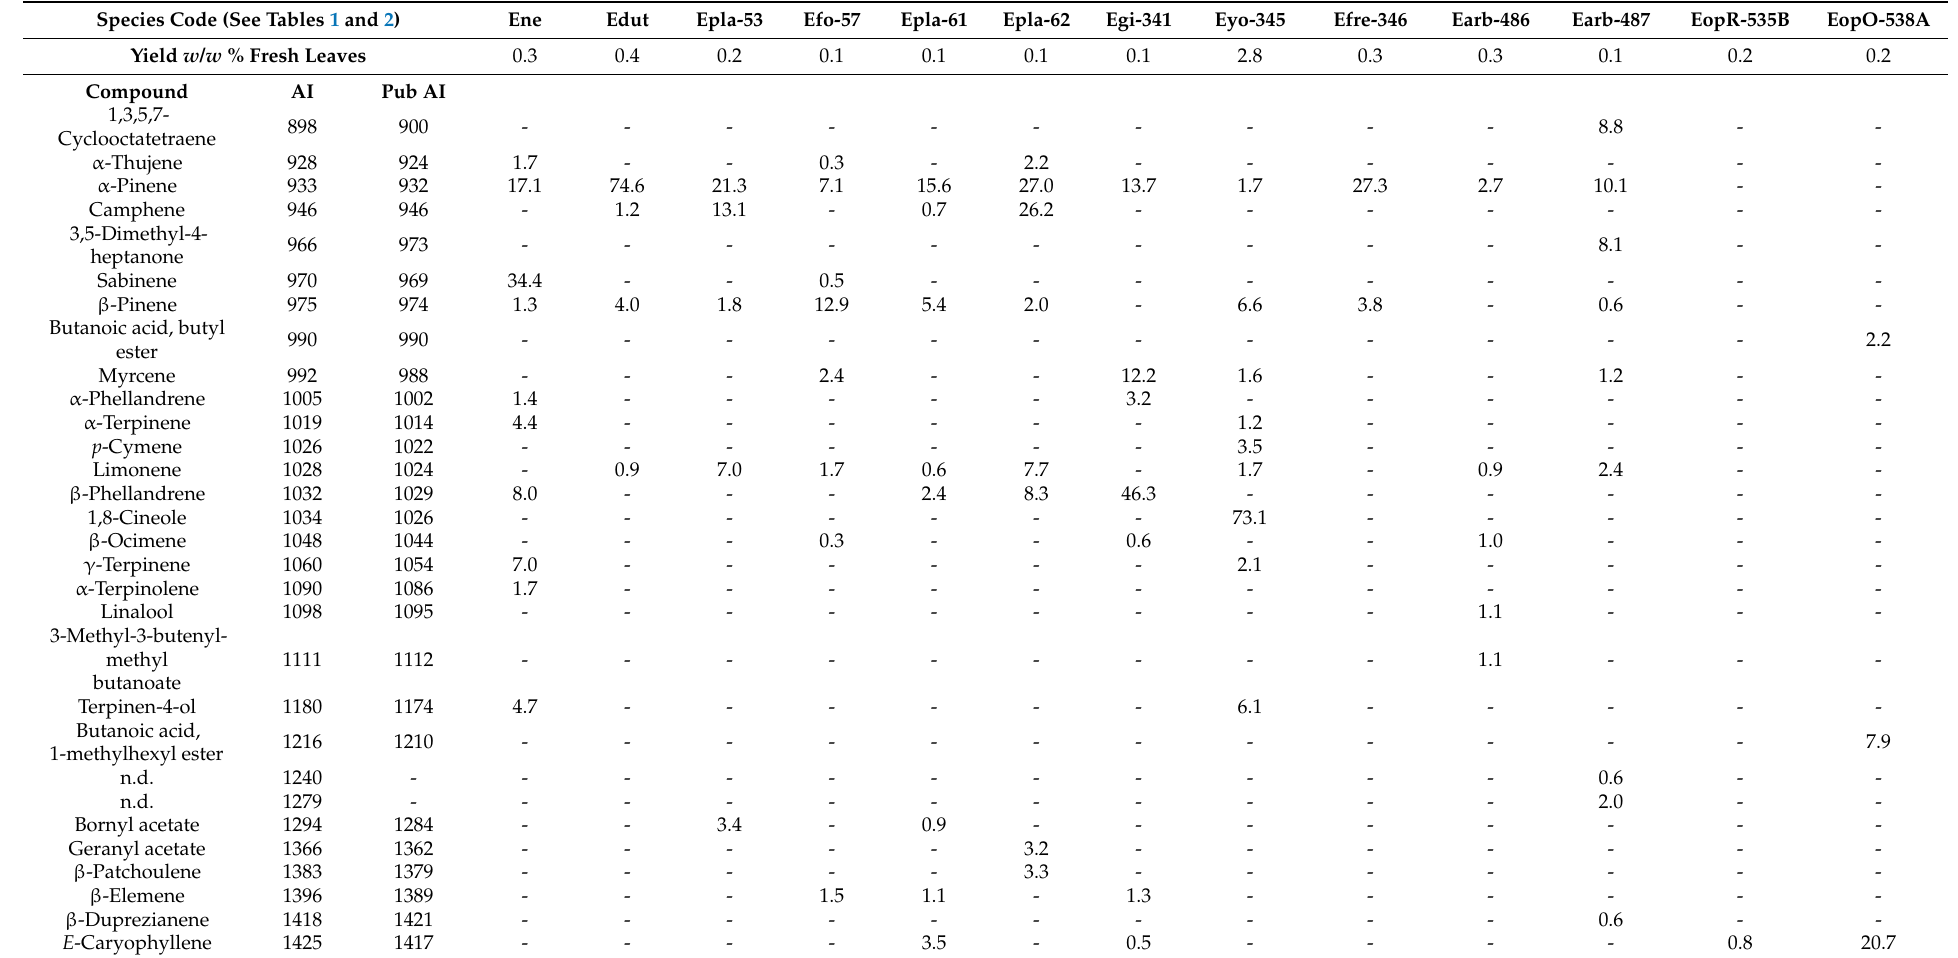
Table 4. Chemistry of essential oils from Eremophila neglecta (Ene), E. duttonii (Edut), E. foliosissima (Efo), E. platycalyx (Epla), E. gilesii (Egi), E. youngii (Eyo), E. freelingii (Efre), E. arbuscular (Earb), E. oppositifolia subsp. rubra (EopR), and E. oppositifolia subsp. oppositifolia (EopO). Species Code (See Tables 1 and